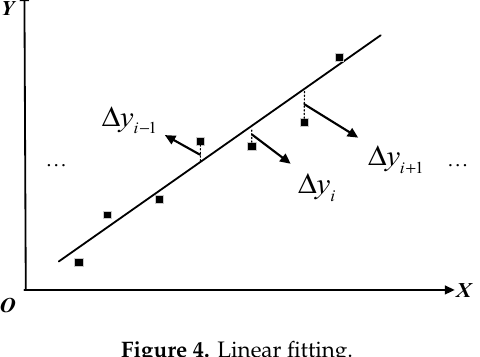
Figure 4. Linear Figure 4. Linear fitting. Figure 4. Linear fitting.